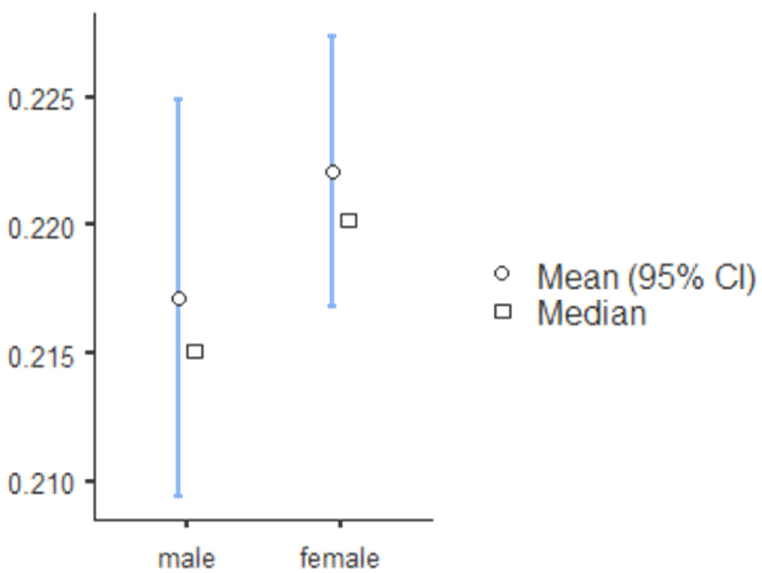
Figure 2. The descriptive chart of mean and median of permanent maxillary left canine index.